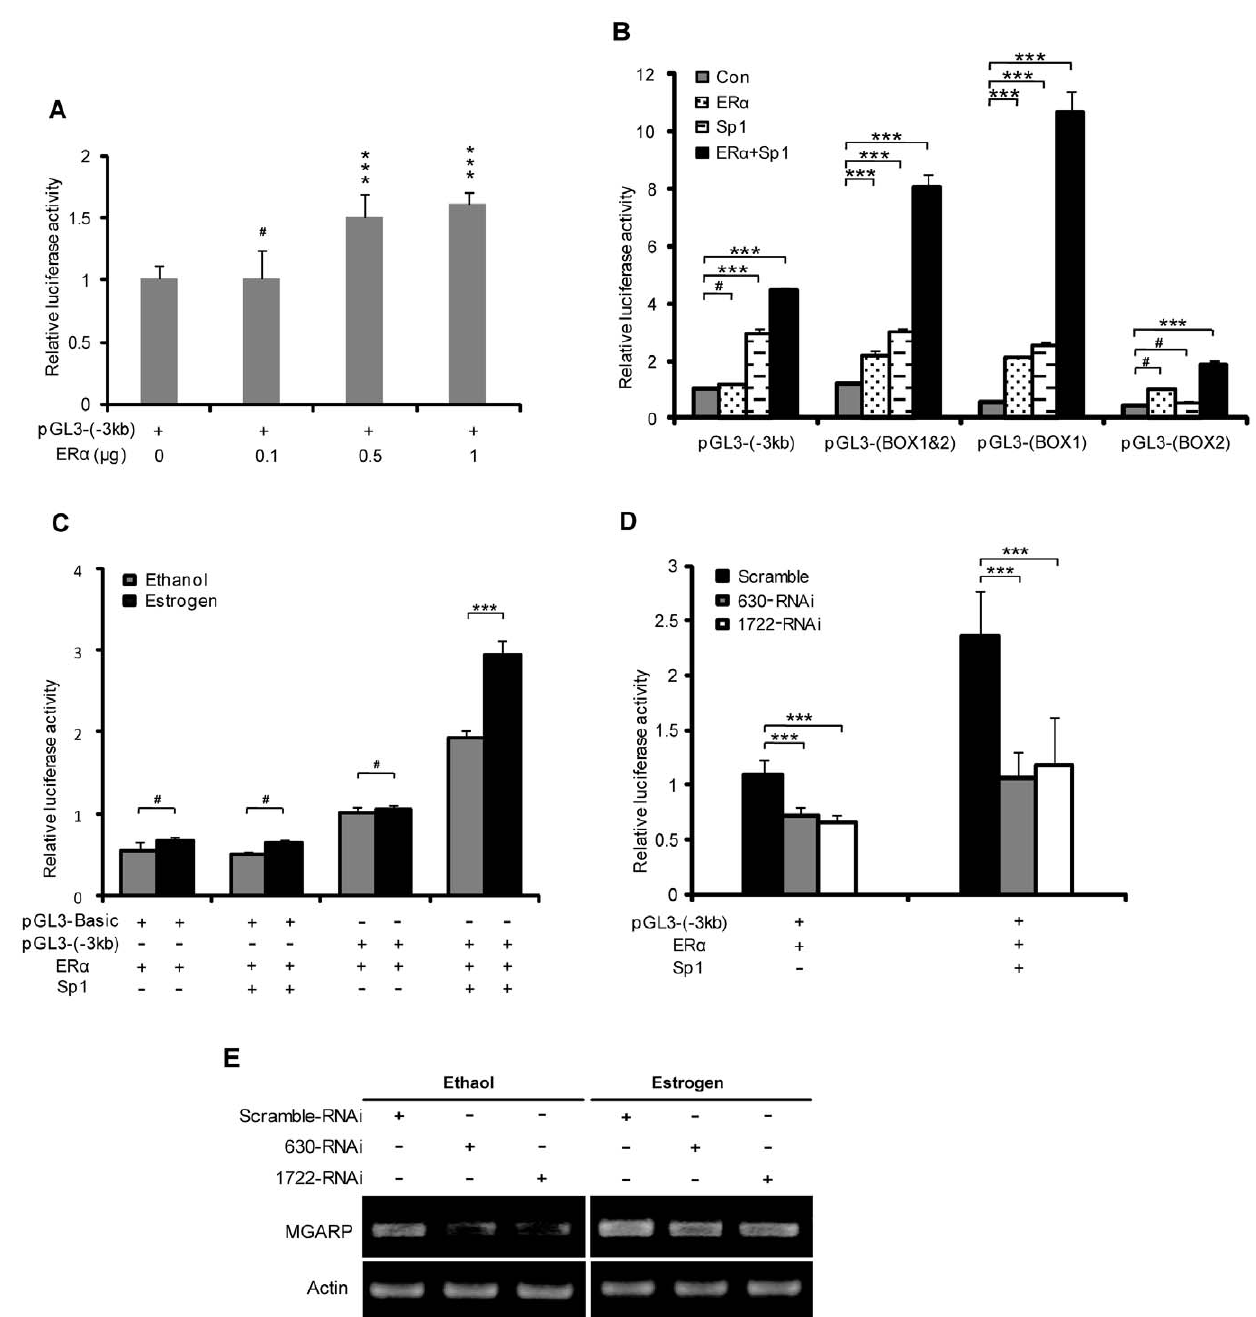
Figure 6. ER a up-regulates the transcription of the MGARP promoter and acts in synergy with Sp1 to activate MGARP transcriptional activity. A. pGL3-( 2 3 kb) reporter and different doses of ER a expression plasmid were co-transfected into HEK-293T cells to determine the dose-dependent manner of ER a in regulating the MGARP promoter by luciferase assay. B. The functional synergy between Sp1 and ER a was determined by cotransfection of the full-length MGARP promoter ( 2 3 kb) or various promoter truncates with or without Sp1 plasmids for Luc assay as indicated. C. The synergystic transactivation activity of ER a and Sp1 under the stimulation of estrogens. The HEK-293T cells were treated with or without 10 nM of estradiol (E2) for 24 hours post transfection of pGL3-( 2 3 kb) and ER a . Subsequently, the Luc assay was performed at 72 hours post transfection. D. Knockdown of Sp1 diminishes the activation function of ER a on MGARP promoter. HEK-293T cells were co-transfected with pGL3-( 2 3 kb) reporter and ER a , together with Sp1-specific RNAi (630-RNAi or 1722-RNAi) or control RNAi, in the absence or presence of exogenous Sp1. *** represents p , 0.001 and # represents p . 0.05 (no significant difference). E. RT-PCR shows that down-regulation of Sp1 with Sp1- specific RNAi (630-RNAi or 1722-RNAi) results in a reduction in endogenous MGARP mRNA expression in HEK-293T cells when stimulated by 10 nM E2. The cells were treated with or without 10 nM E2 for 24 hours post transfection and total RNA was harvested at 72 hours post transfection for semiquantitative RT-PCR analysis.